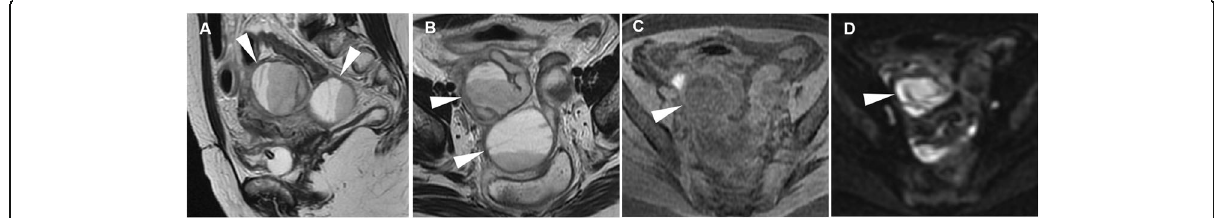
Fig. 15 Acute pyosalpinx in a 44-year-old woman with a history of surgically treated pelvic endometriosis 5 years earlier, suffering from abdominal pain, fever and diarrhoea. Sagittal ( a ), axial ( b ) T2-weighted images and axial fat-suppressed T1-weighted ( c ) image show a distended right fallopian tube (arrowheads) with thickened walls and internal fluid-fluid levels. On axial DWI ( b = 800 s/mm 2 ) image ( d ), the involved